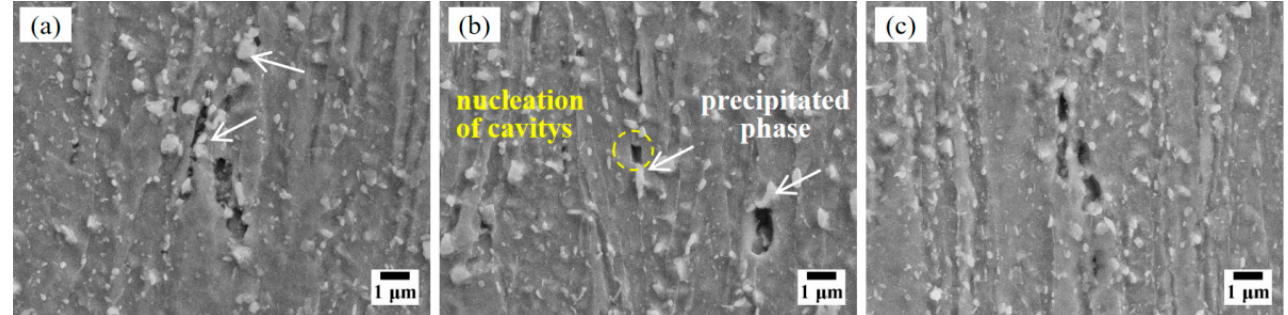
Figure 12. SEM images of the necking area of the ( a ) 450 °C, ( b ) 500 °C, and ( c ) 550 °C tensile samples. All samples were subjected to Max.SPWHT.